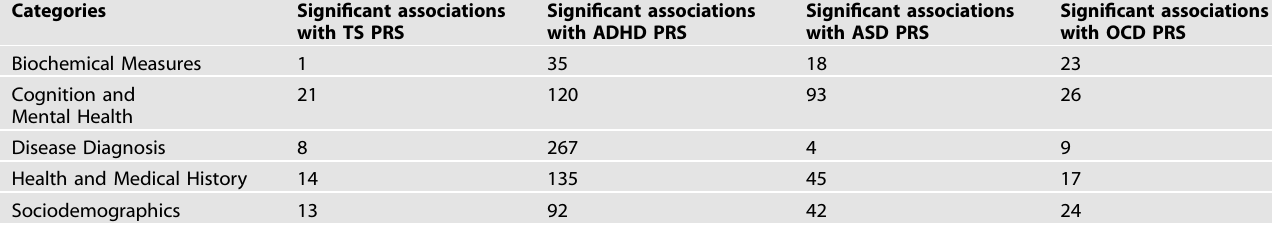
Table 2. Number of signi fi cant associations observed for the genetic risk of different neurodevelopmental disorders.